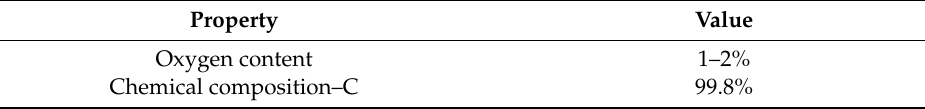
Table 4. The basic properties of graphene.